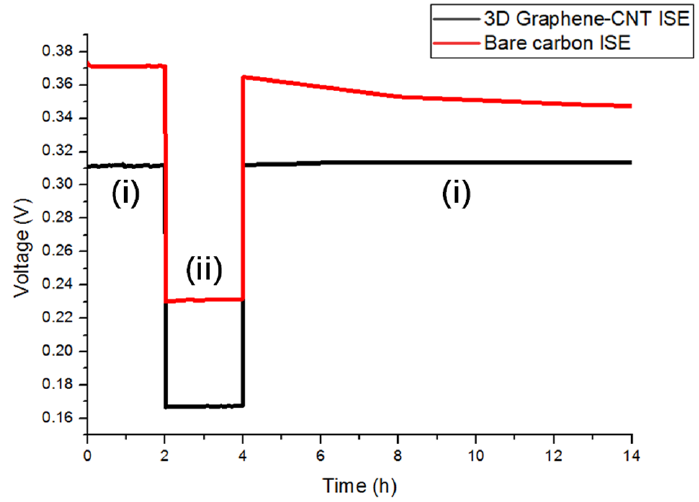
Figure 8. Water layer test results for the 3D Graphene–CNT ISE and bare carbon ISE, determined in ( i ) 0.1 M NH 4 Cl and( ii ) 0.1 M NaCl.